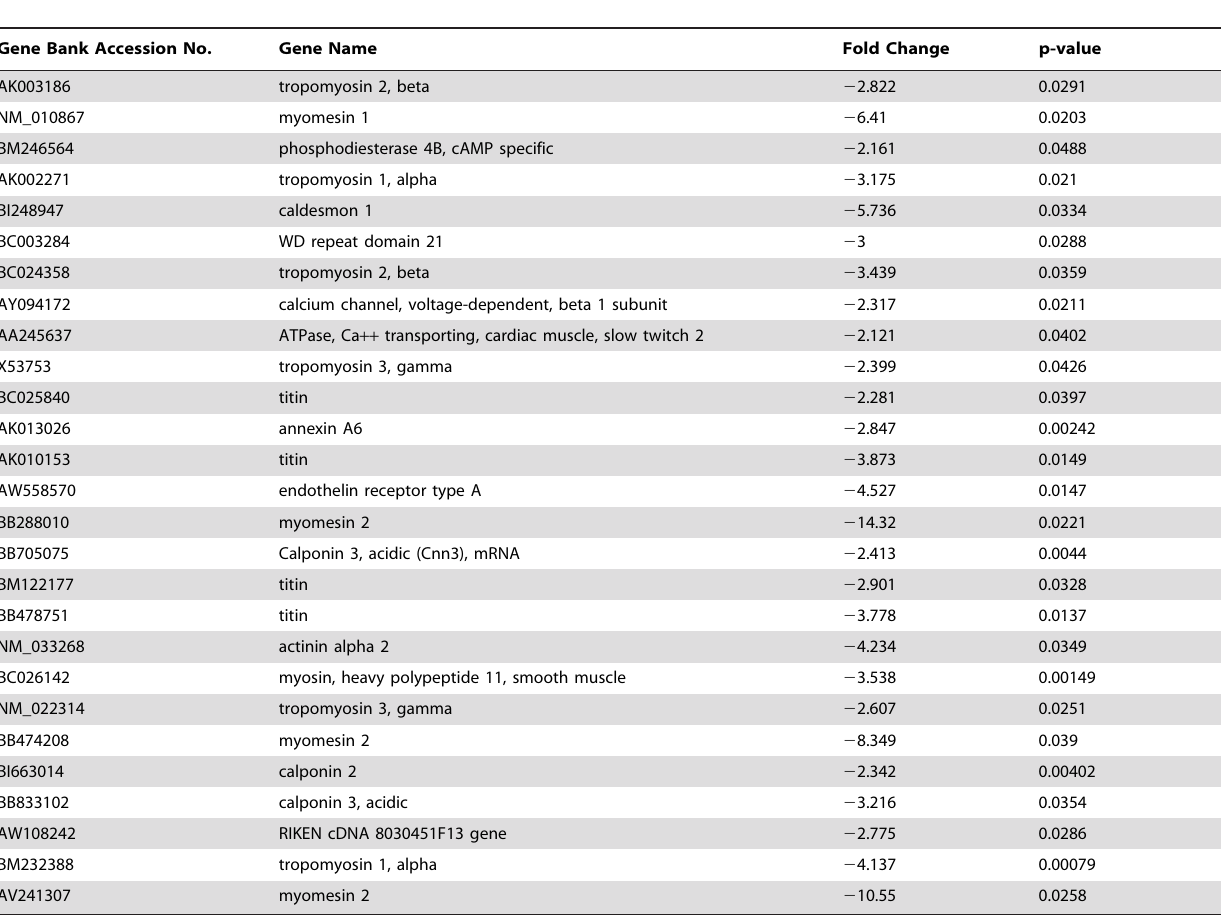
Table 6. Downregulation of muscle contraction genes in mouse skeletal muscle at 4 days 2-AA treatment versus control muscle.